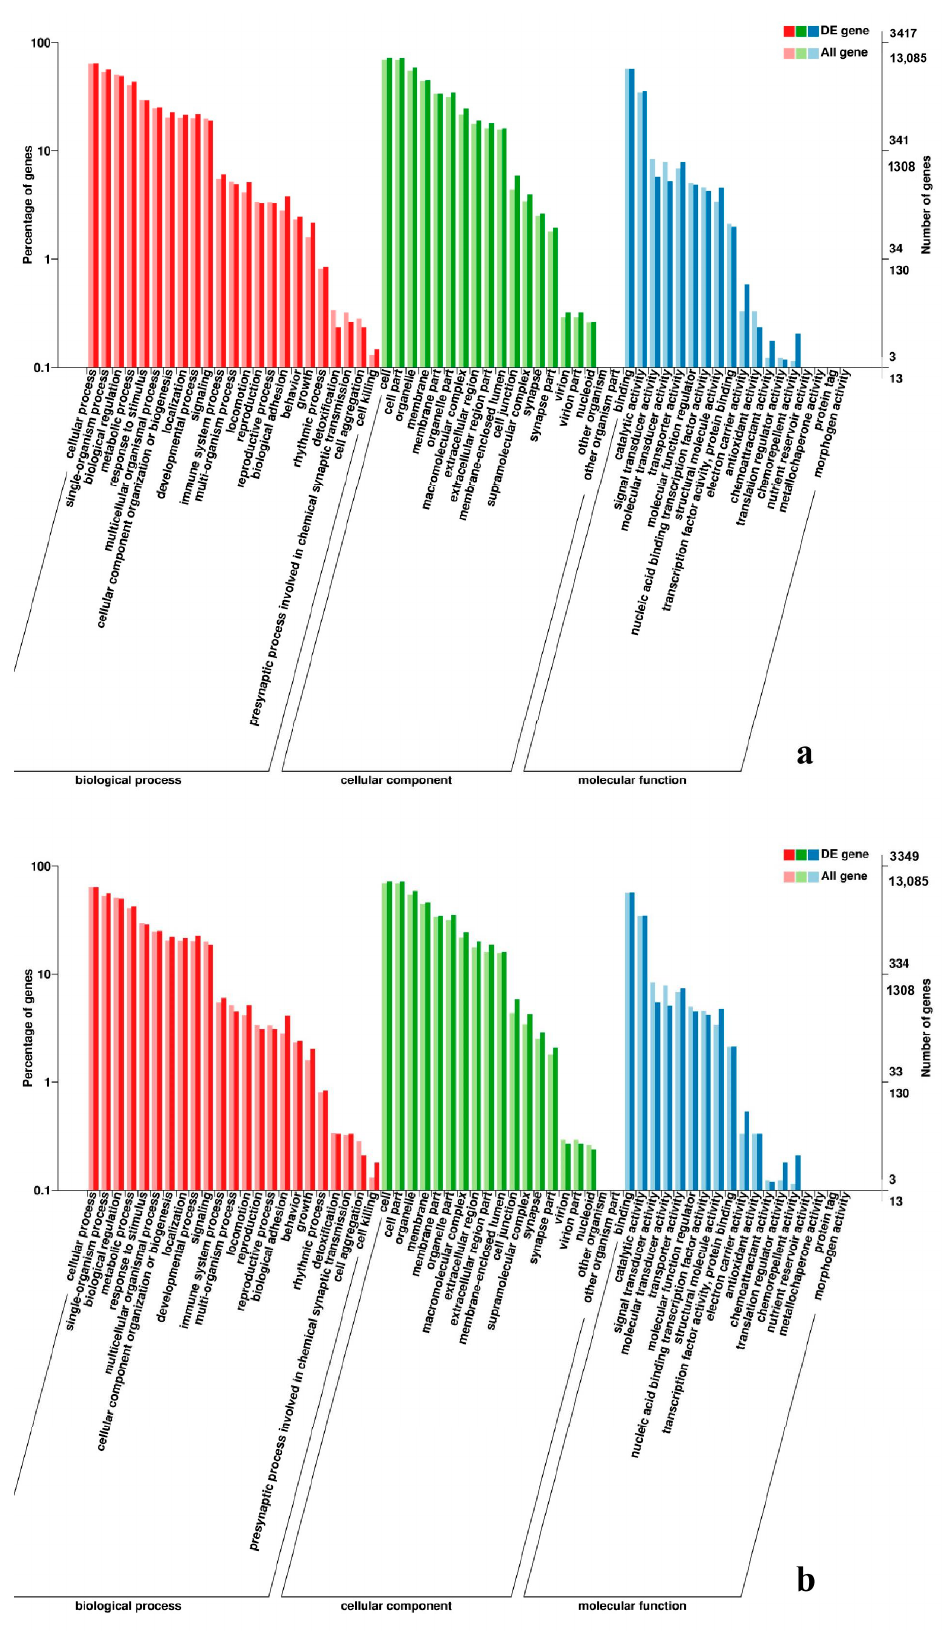
Figure 7. GO enrichment analysis of DEGs in leg muscle. ( a ) BE17L_vs_BE31L; ( b )